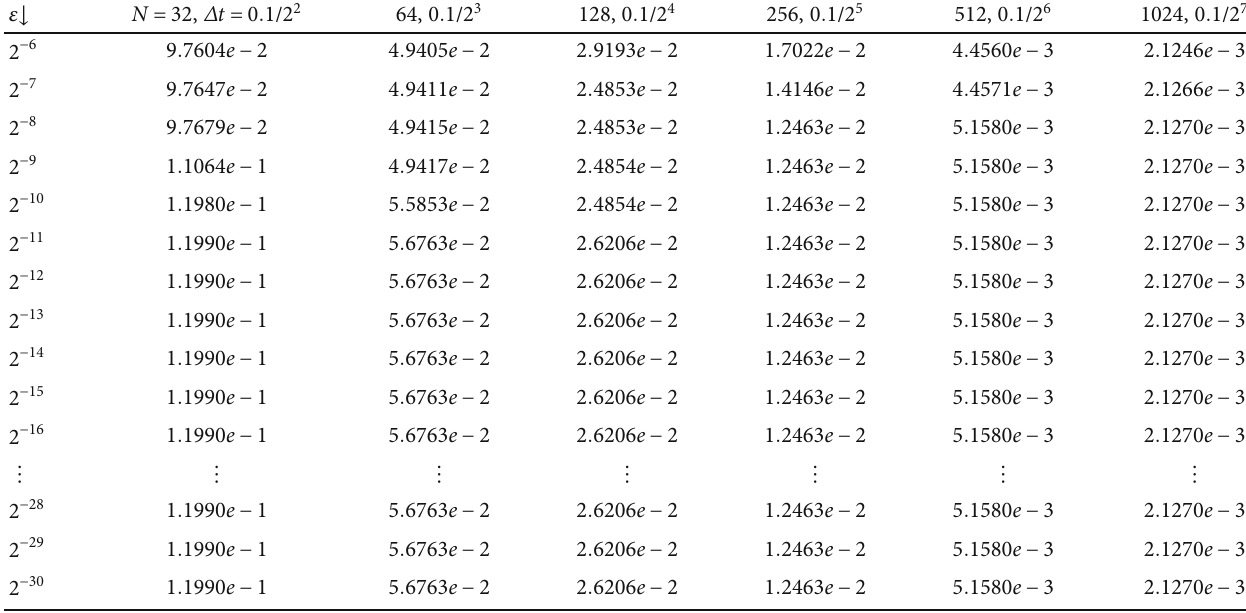
ε and λ = 0 : 99 . ε for various